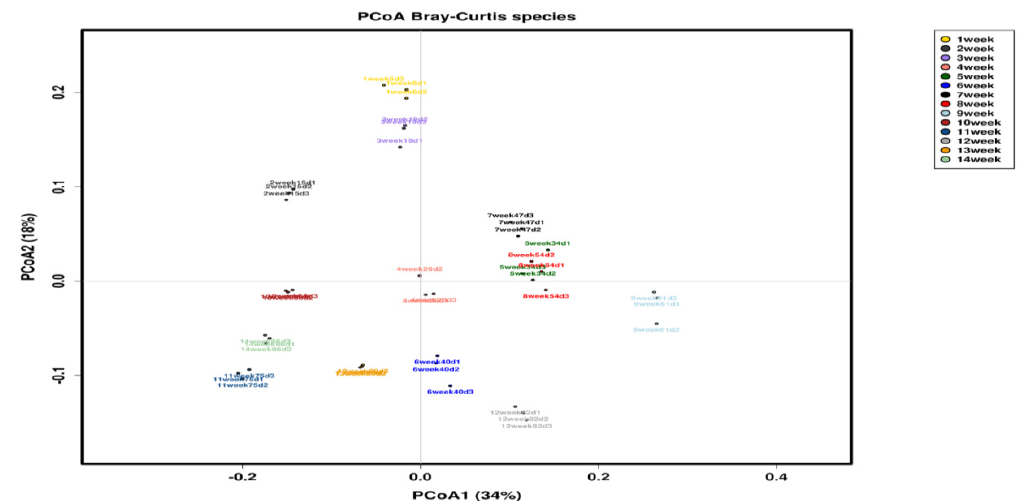
Figure 3. Representation of the beta-diversity through the Weighted UniFrac principal coordinate analysis (PCoA), plot and the different colors indicate the different week of sample.